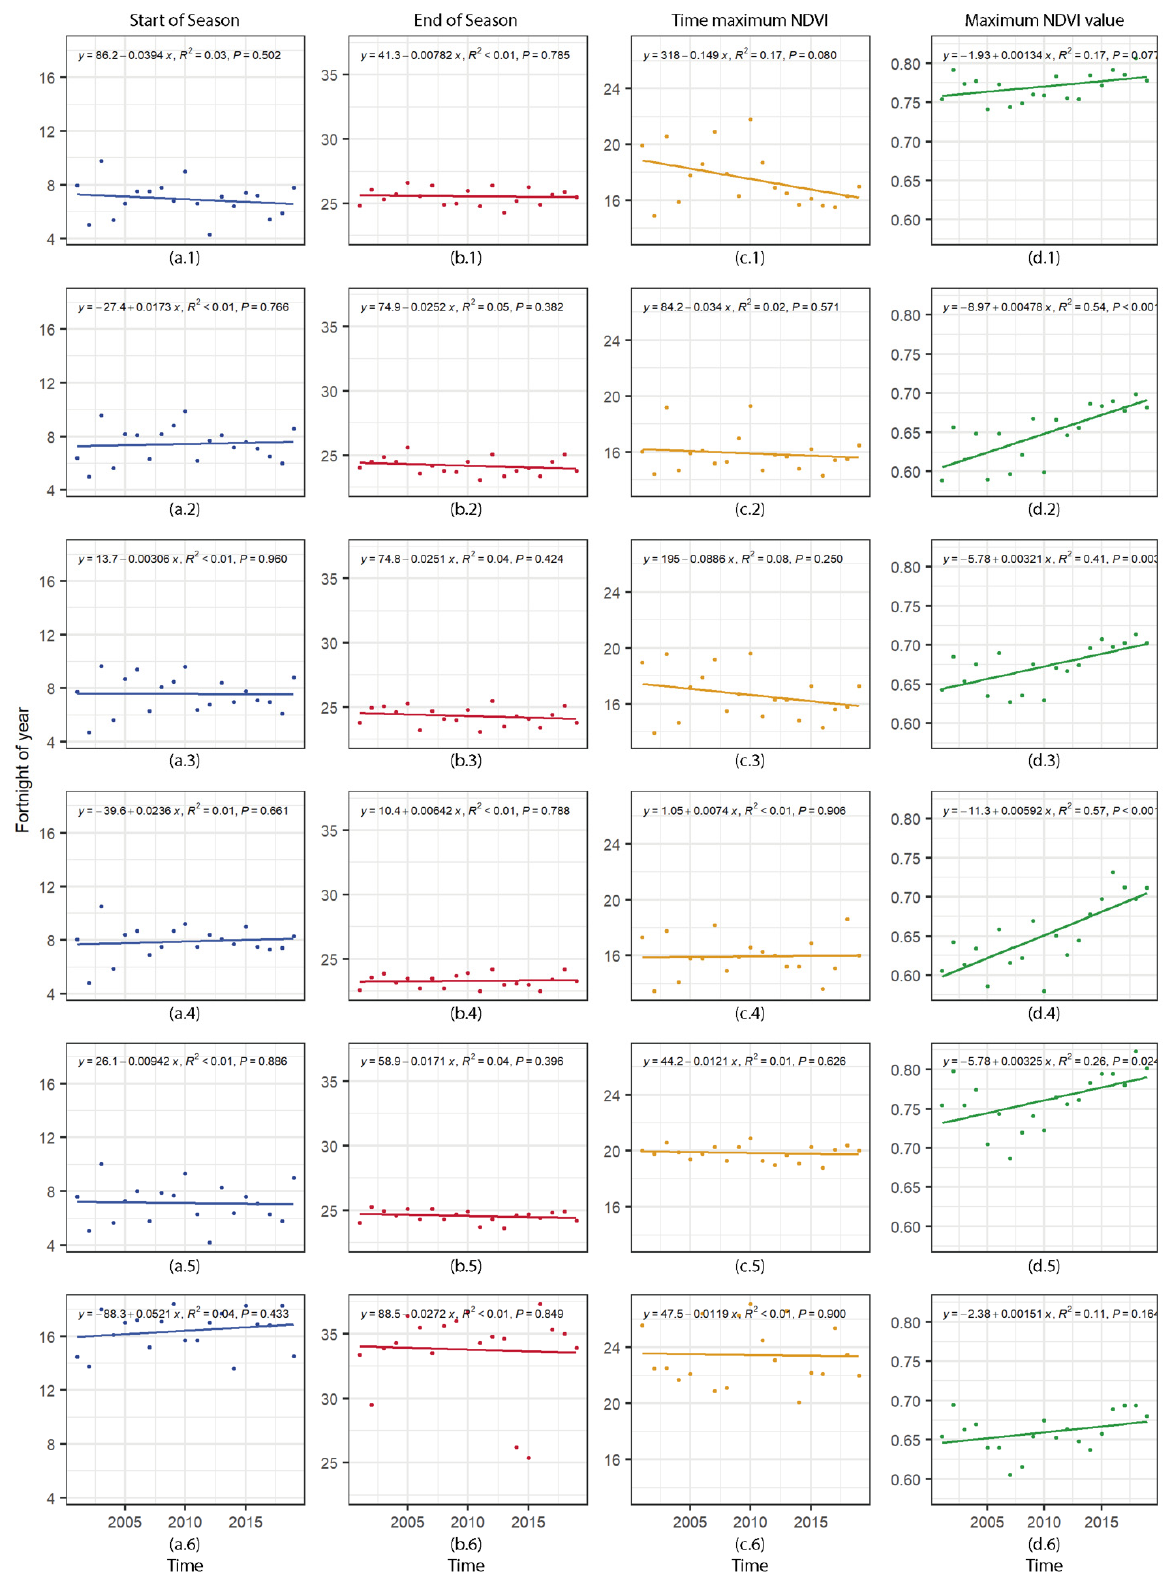
Figure 7. Evolution of phenological metrics: ( a ) start of season, ( b ) end of season, ( c ) peak value of season and ( d ) NDVI at the peak, as a function of year from 2001 to 2020 in the six agro-climatics regions of Biobio: ( 1 ) Secano Costero, ( 2 ) Secano interior, ( 3 ) Depresión Intermedia, ( 4 ) Cordón Isla, ( 5 ) Precordillera and, ( 6 ) Cordillera.